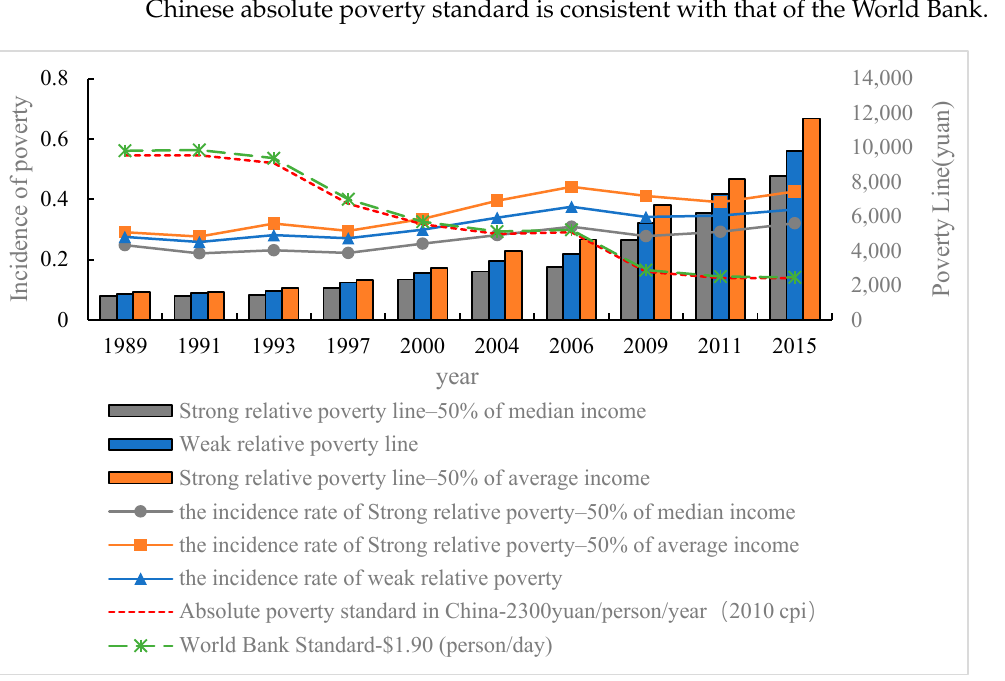
Figure 1. Absolute poverty and relative poverty in China from 1989 to 2015.